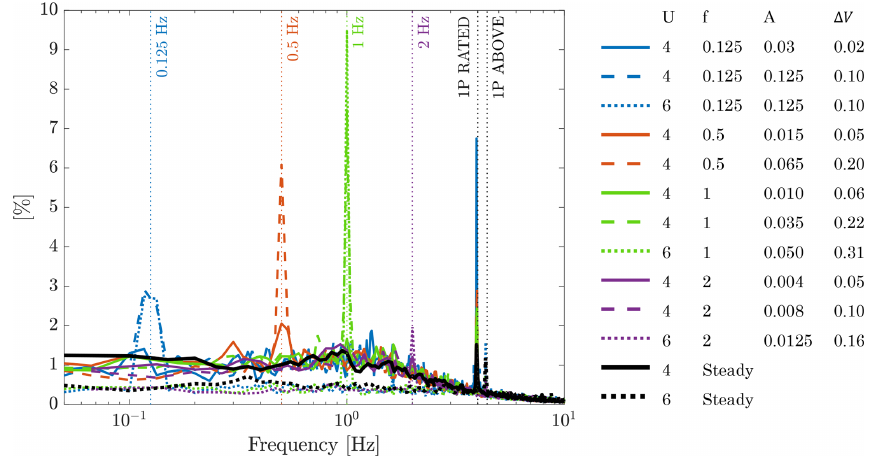
Figure 12. Space-averaged PSD of the hub-height axial velocity for different frequencies. The vertical dotted lines mark the frequencies of surge motion and the rotor frequency. In the legend U is the mean wind speed, f the surge frequency, A the surge amplitude, and (cid:49)V the maximum surge velocity.